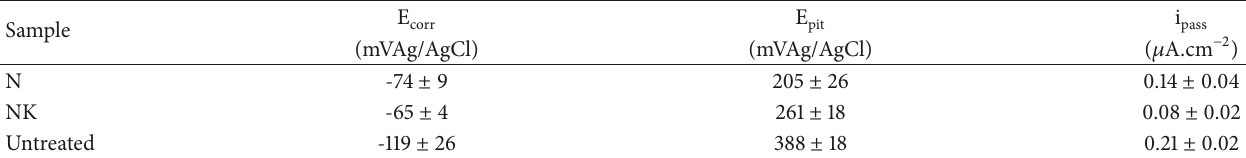
Table 7: Electrochemical parameters determined from the potentiodynamic polarization curves.